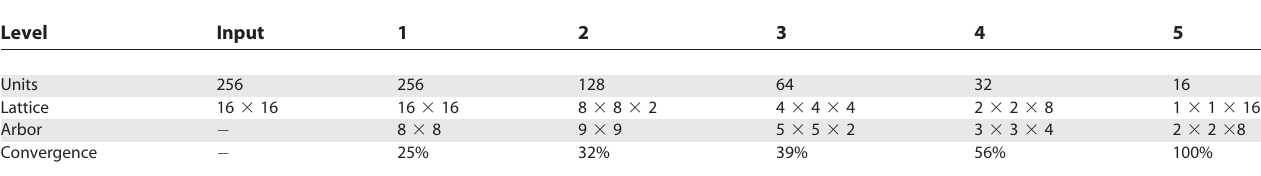
Table 1. Feed-Forward Network Connectivity